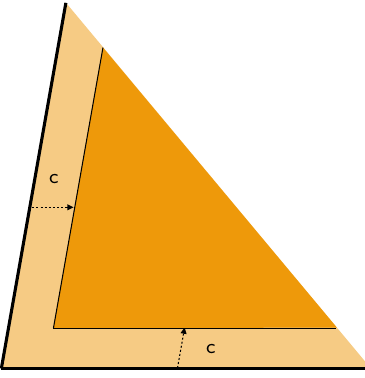
˜ [0] and ˜ K [ c ] for a two-dimensional setting. The darker K ˜ ˜ X X